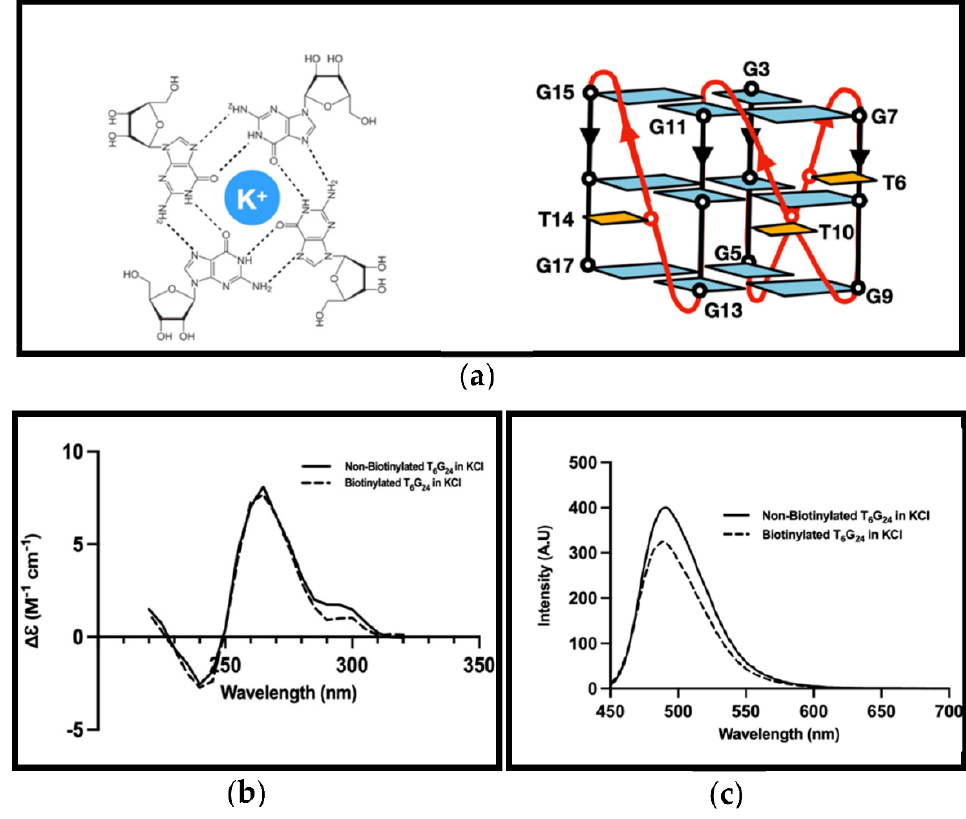
Figure 2. G4 formation analysis. ( a ) G-Quadruplex structure (left) and schematic representation of main folding topology formed by the G4 structure used in this experiment (T 6 G 24 ) in vitro (right). ( b ) CD analysis of non-biotinylated (solid lines) and biotinylated (dashed lines) T 6 G 24 sequence formed in the presence of KCl. ( c ) Fluorescence analysis of non-biotinylated (solid lines) and biotinylated (dashed lines) T 6 G 24 sequence formed in the presence of KCl.